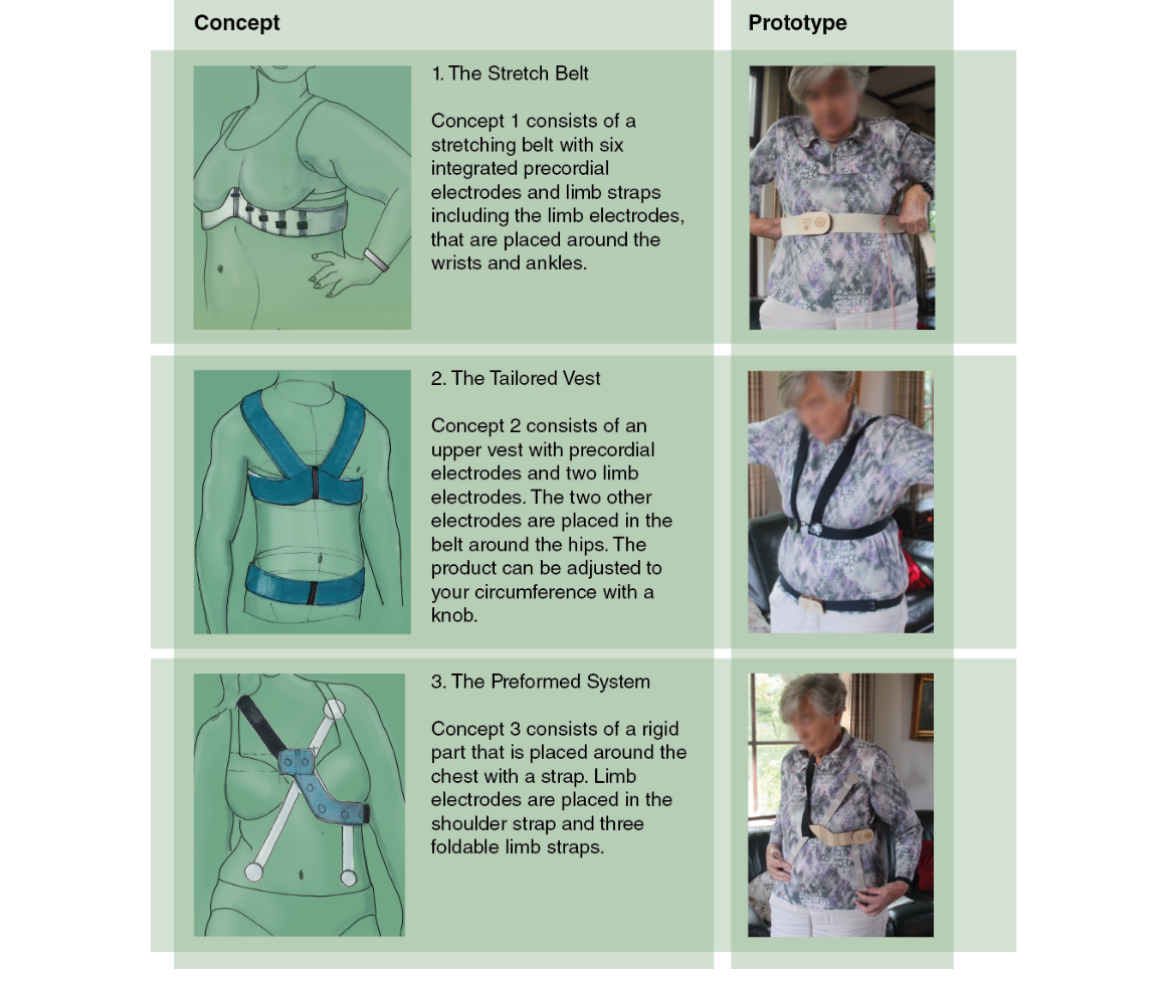
Figure 3. Concept design and mock-ups.